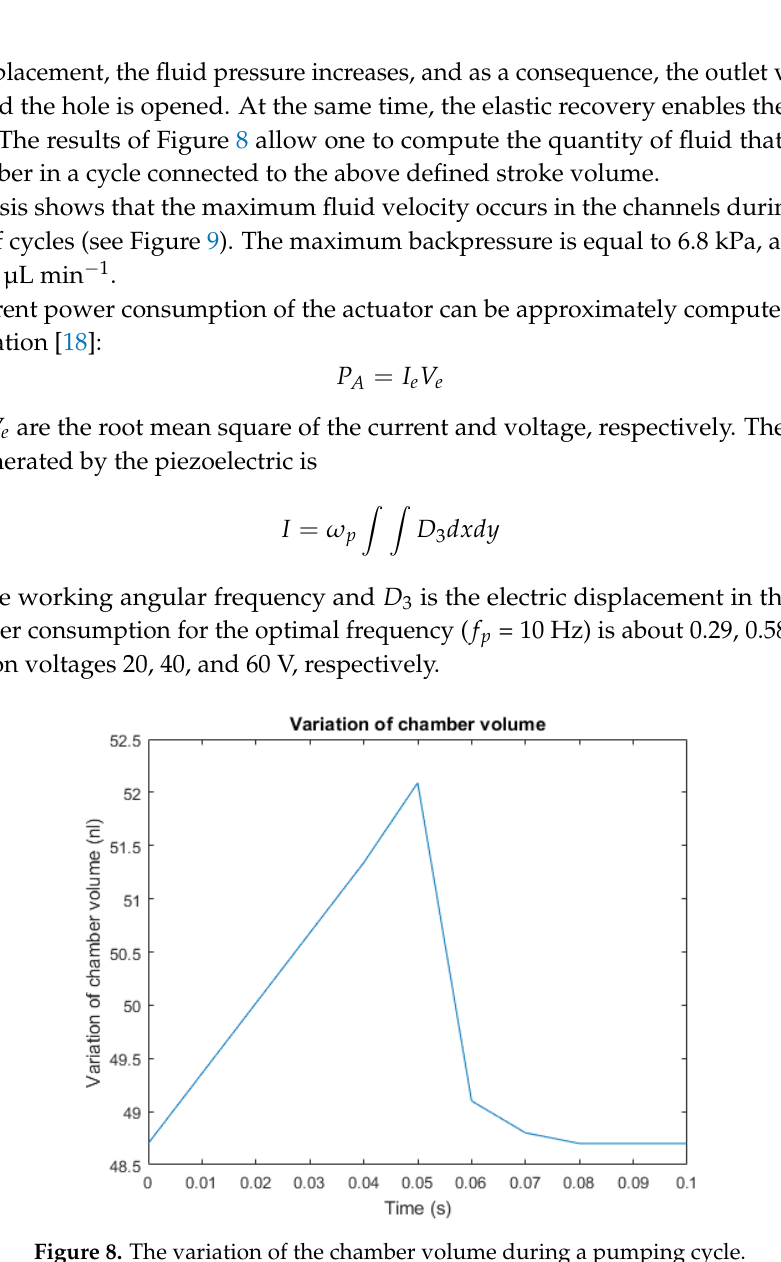
Figure 8. The variation of the chamber volume during a pumping